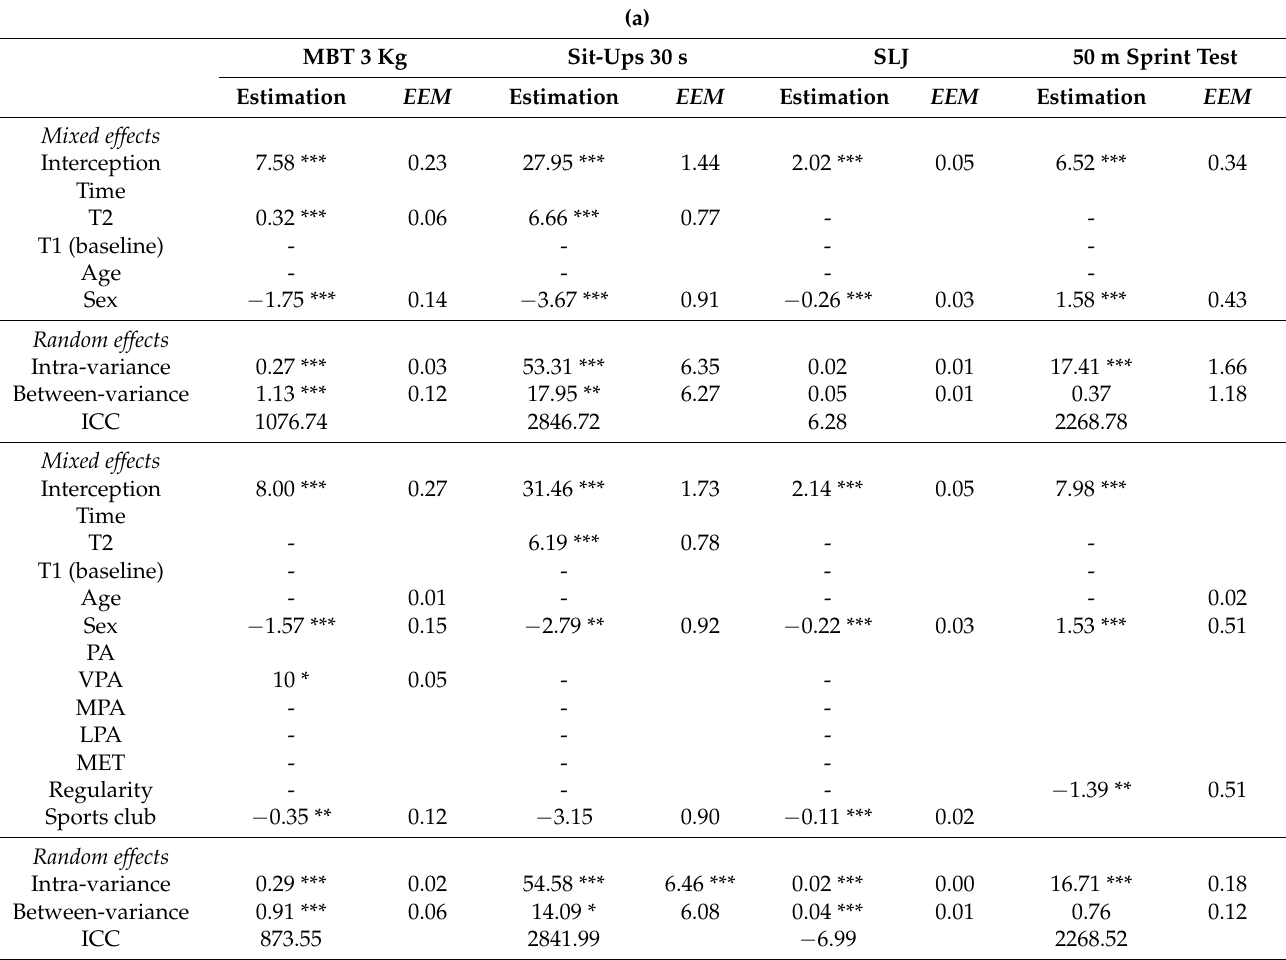
Table 3. Multilevel analysis of the physical fitness tests of the